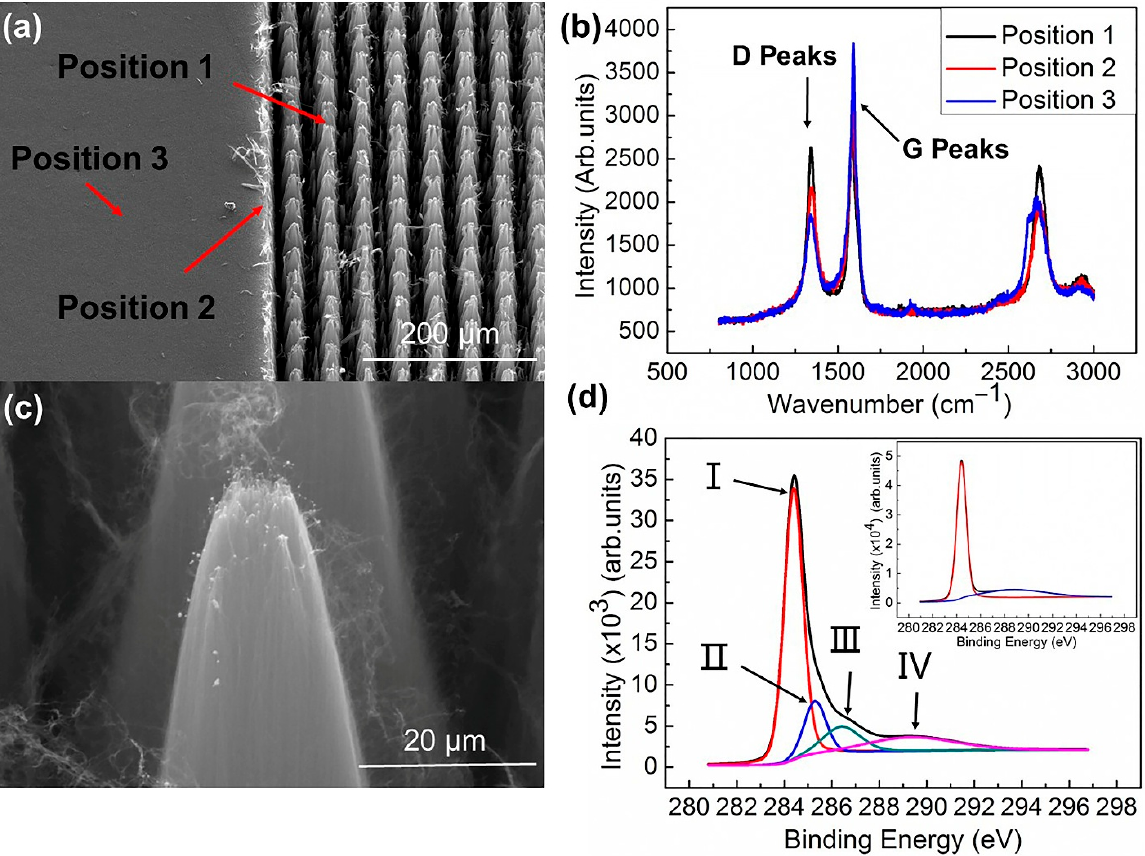
Figure 2. ( a ) A typical SEM image of a patterned VACNT sample where the right side has been processed. Position 1 is the top of the laser processed array, position 2 is the junction of the processed position and the unprocessed position, and position 3 is the unprocessed position. ( b ) Corresponding Raman spectra at the positions 1, 2, and 3. ( c ) New large exotic nanoparticles of Al and Fe on the processed VACNT. ( d ) The C 1s XPS peaks for processed VACNT. The appearance of N and other trace elements, as well as the increase in O content in the samples after UV laser processing is likely due to reactions with some elements in the